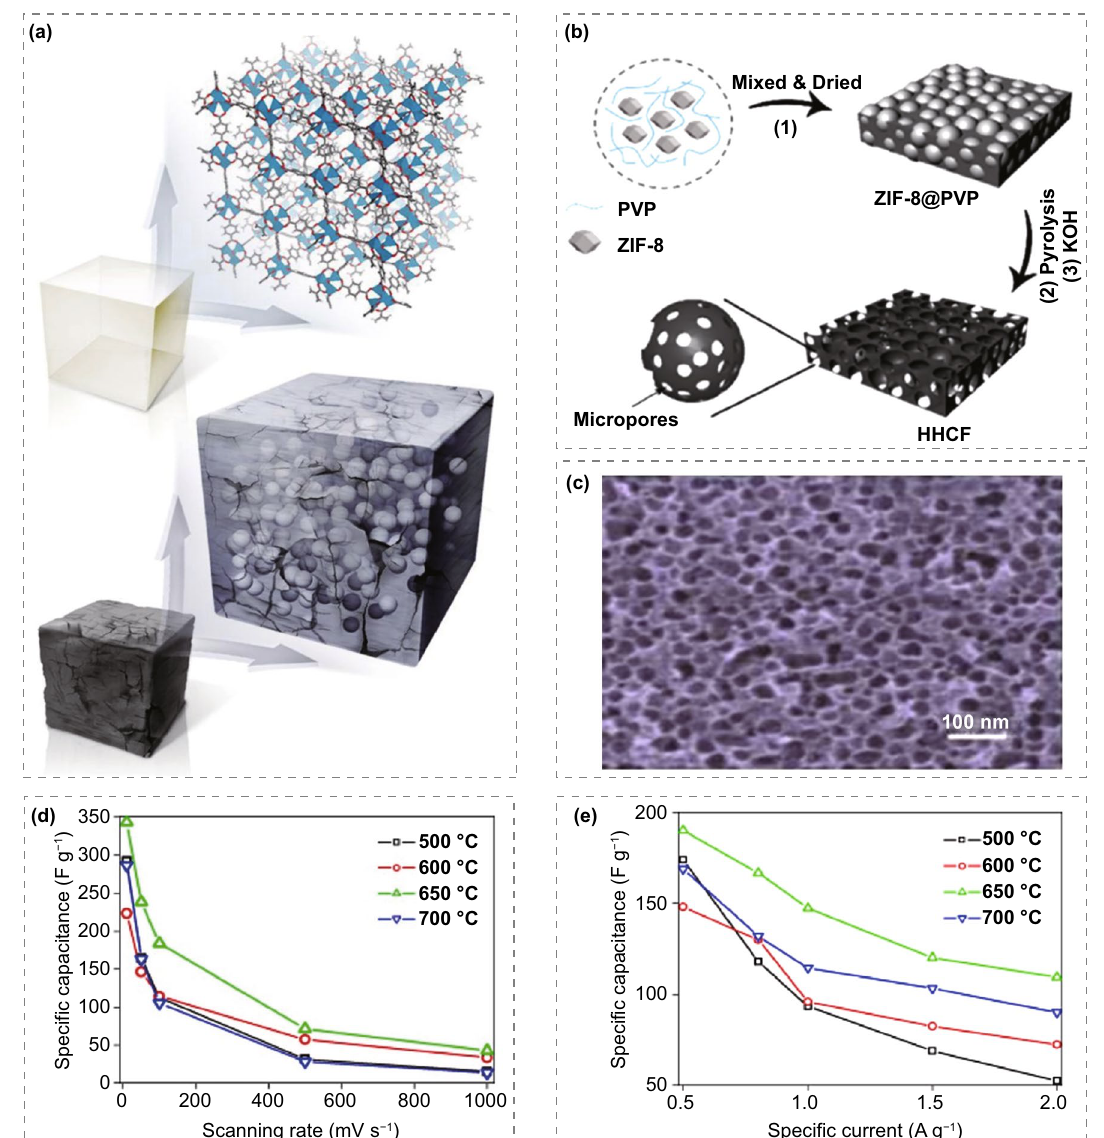
Fig. 10 a Schematic synthesis diagram of IRMOF-1 (top) and carbon-coated ZnO QDs without agglomeration produced by IRMOF-1 after controlled pyrolysis (bottom). Reprinted with permission from Ref. [134]. Copyright 2013 American Chemical Society. b HHCF synthesis pro- cess diagram. c SEM images of HHCF. Reprinted with permission from Ref. [136]. Copyright 2019 Elsevier B.V. d Specific capacitance with respect to scan rate. e Specific capacitance as a function of current density. Reprinted with permission from Ref. [138]. Copyright 2018